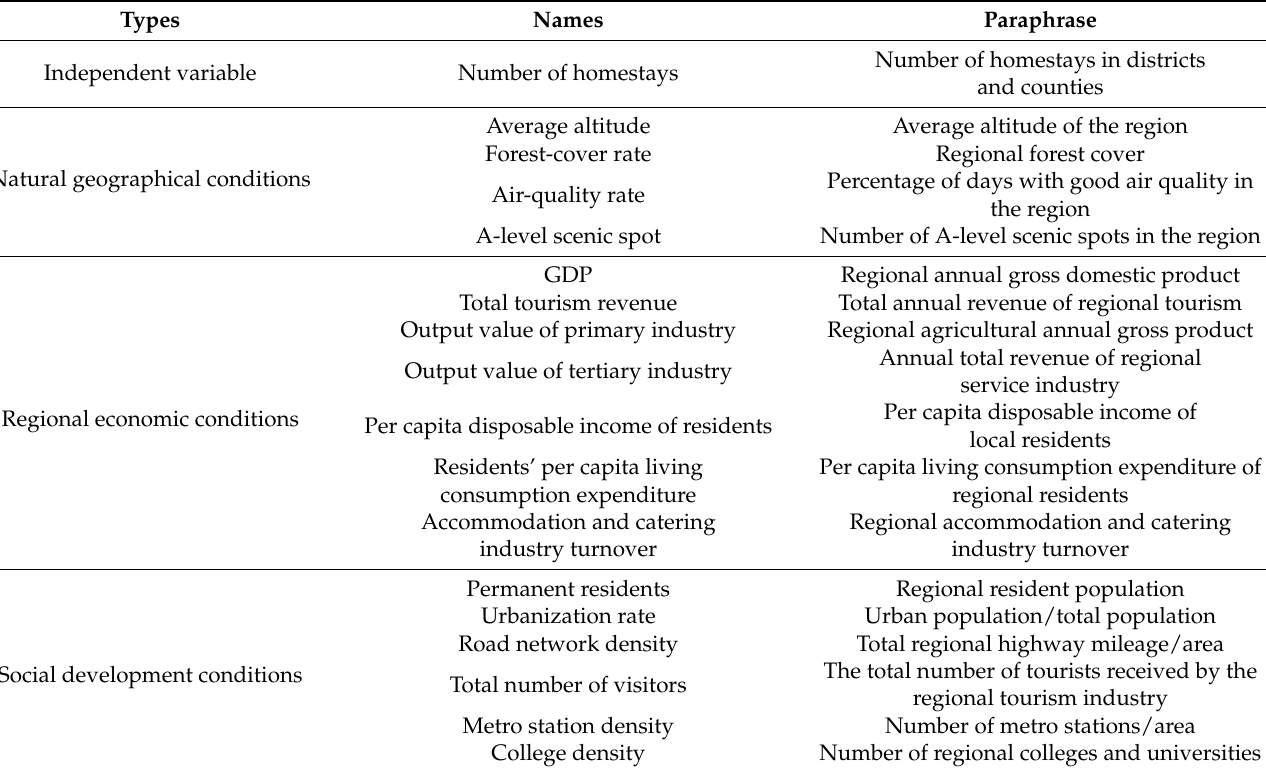
Table 1. Influencing factors of homestays in